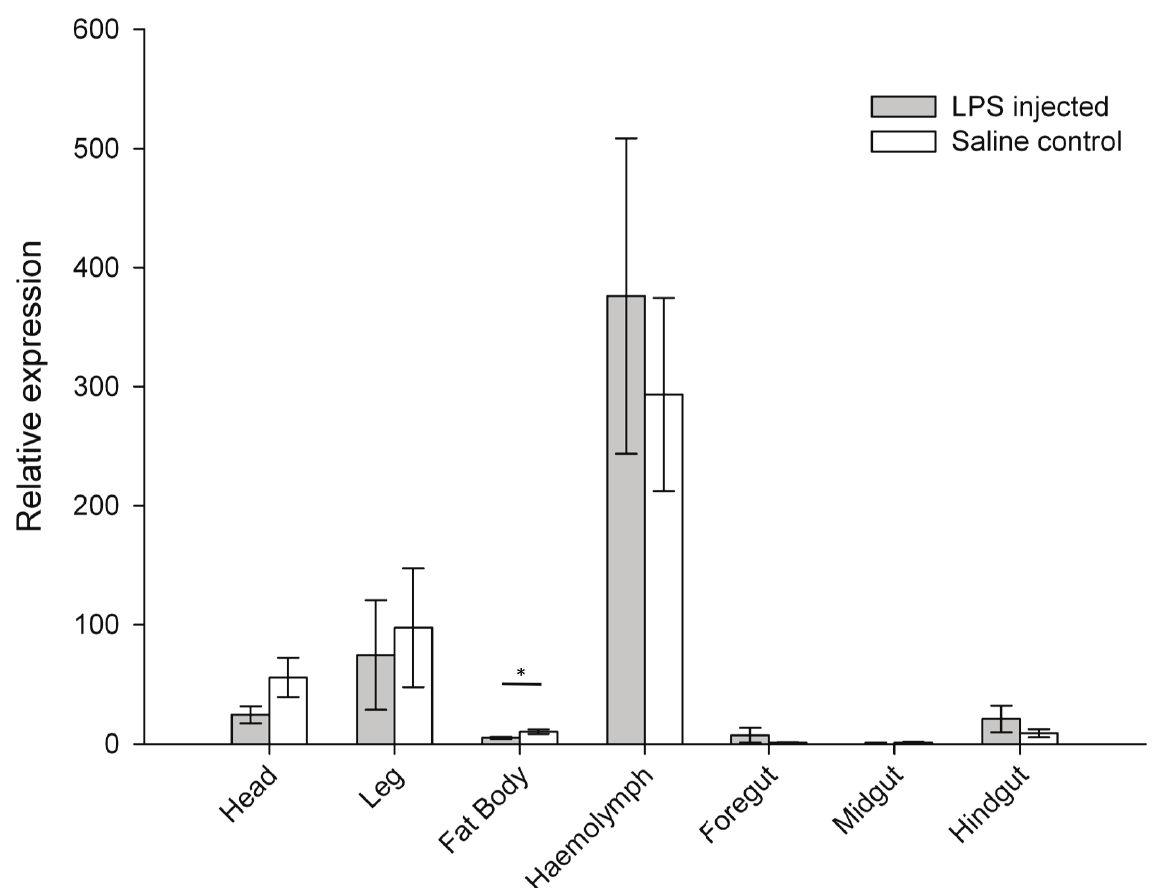
Figure 2. Relative expression levels of the gene coding for gram-negative binding protein 1 (GNBP1) across seven tissue types in LPS-injected and saline control Locusta migratoria. Error bars = ± SEM. * p <